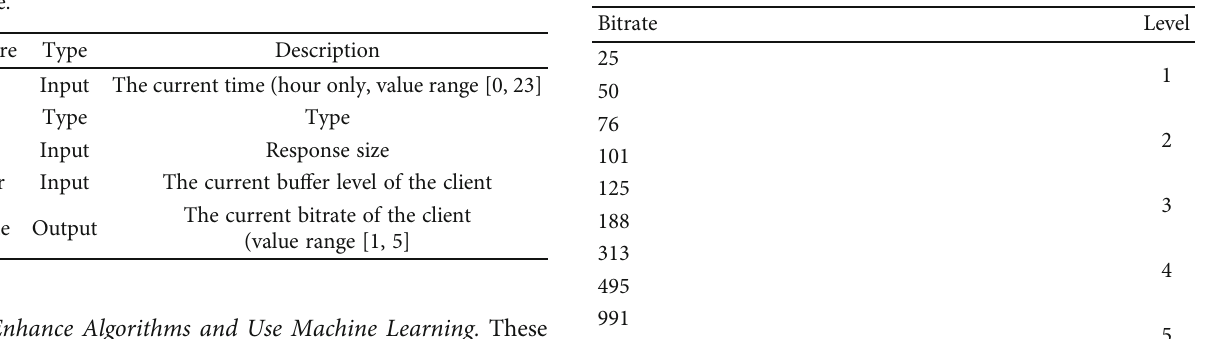
Table 2: Categorized bitrate